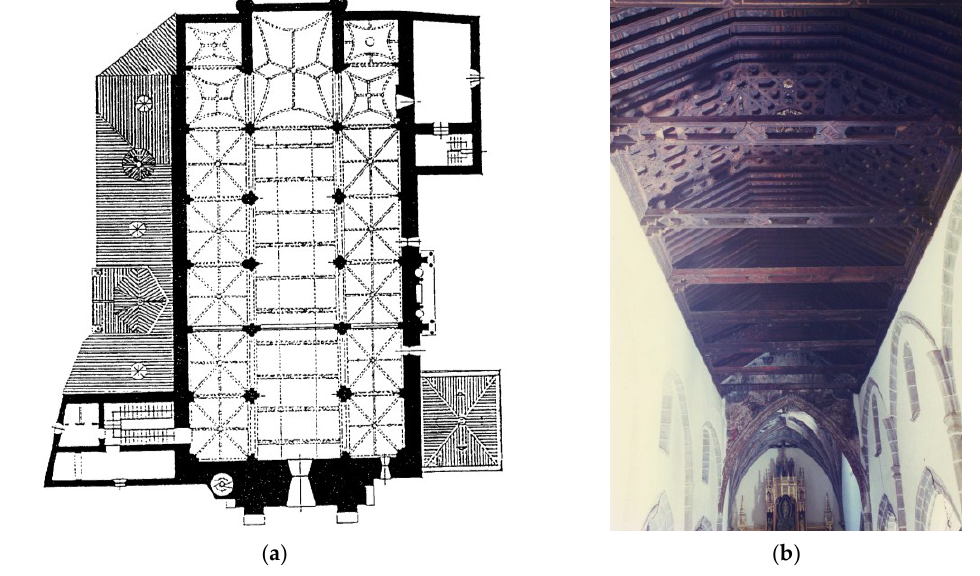
Figure 8. Parish church of San Juan Bautista. Hinojosa del Duque (Cordoba): ( a ) floor plan. © Junta de Andalucía; ( b ) wooden ceiling of the central nave. Photo took by author.